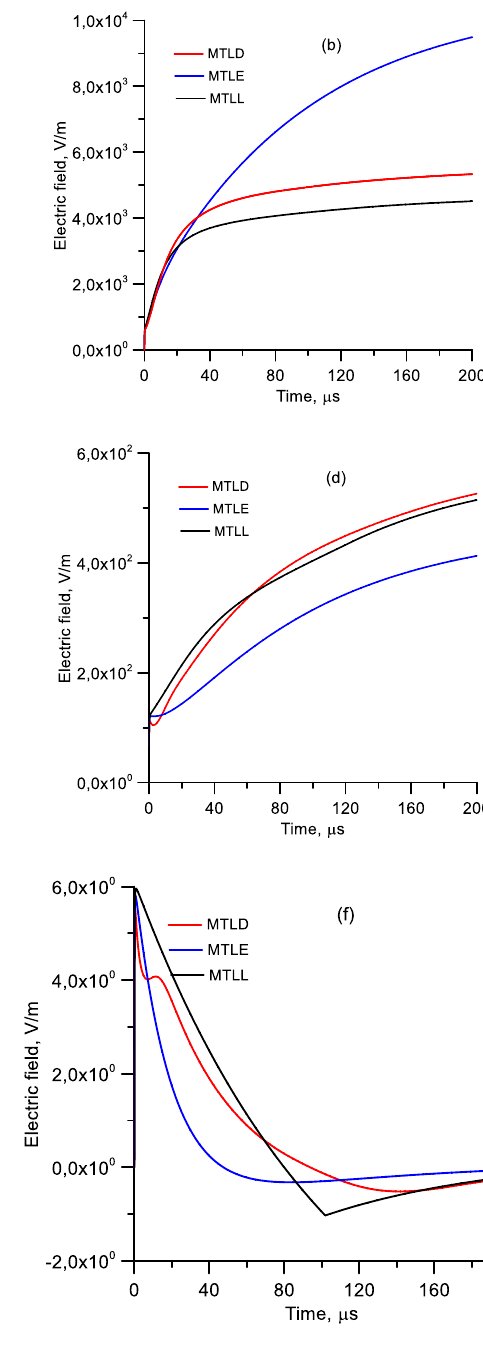
Figure 11. Electric field of first return strokes at different distances as predicted by the MTLD (with dispersion and decreasing velocity profile with λ v = 10 km), MTLE and MTLL models. ( a ) 50 m, ( b ) 1 km, ( c ) 2 km, ( d ) 5 km, ( e ) 10 km and ( f ) 100 km. In the MTLE model, λ = 2.0 km and, in the MTLL model, H = 10 km are used as model parameters. In the MTLE and MTLL models, the return stroke speed remains constant at 1.0 × 10 8 m/s.